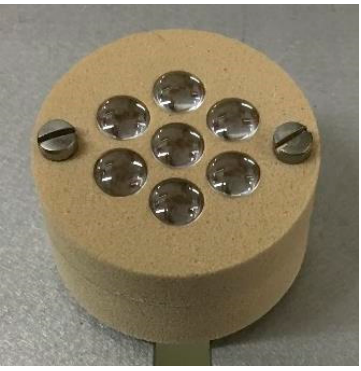
Figure 2. NASA Ames seven-lens sensor head (31.75 mm diameter) with 6 mm lenses.